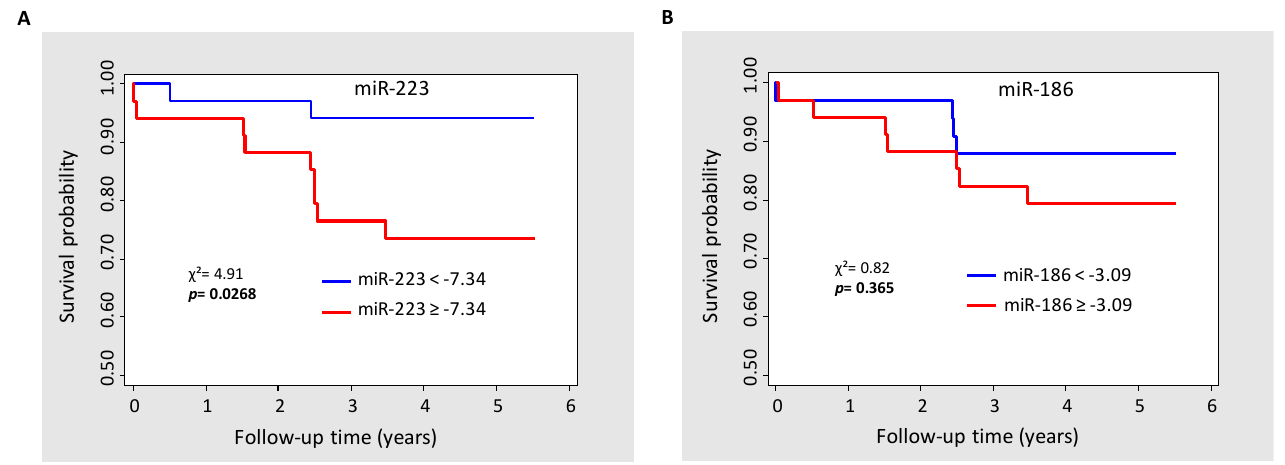
Figure 2. Kaplan–Meier survival estimate according to the median of miR-223 ( A ) and miR-186 ( B ). χ ², Chi-squared test.